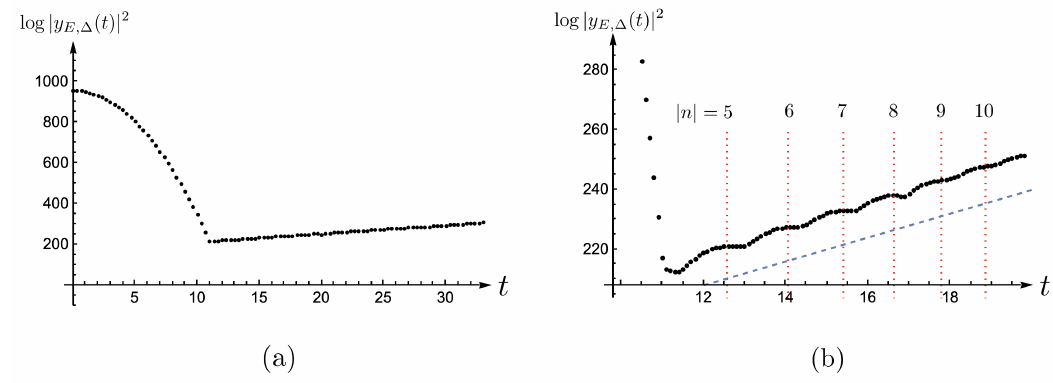
√ α 0 , √ α 0 . Due to numerical reasons, we only √ α 0 , whose meaning is explained